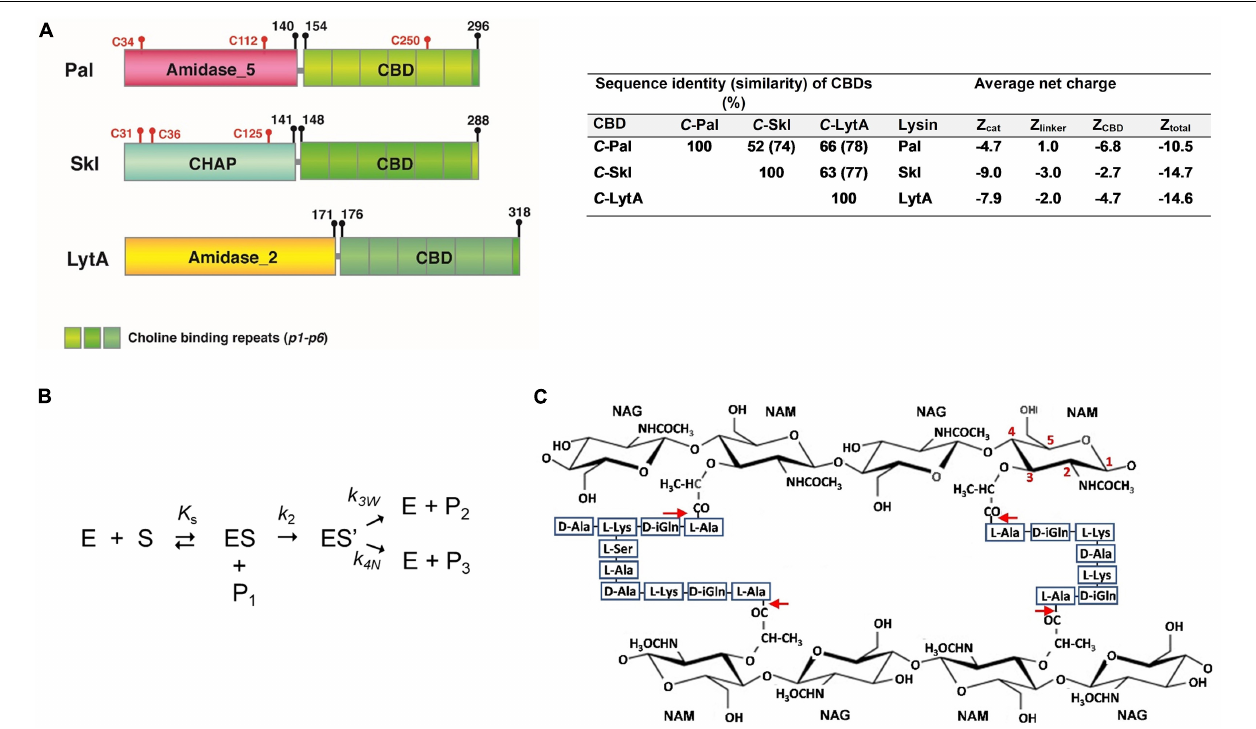
FIGURE 1 | (A) Schematic representation of Pal, Skl, and LytA NAM-amidase structures. Domains [ Amidase_5 (PF05382), CHAP (PF05257), Amidase_2 (PF01510)], choline-binding repeats (PF01473), and linkers are specified by different colors. Initial and final amino acids and cysteine positions are indicated. Sequence similarity between domains and average net charges are summarized on the right side. (B) Schematic representation of the reaction pathway for the hydrolysis by cysteine-peptidases. E and S are the free enzyme and the substrate, ES the non-covalent enzyme-substrate complex, ES’ the acyl-enzyme formed by the nucleophilic attack of the catalytic cysteine, P 1 the leaving amine product, P 2 the acyl product formed by water attack, and K s , k 2 , and k 3 w the dissociation constant of the non-covalent complex, the acylation constant, and the water-mediated deacylation constant, respectively. P 3 is the product resulting from the attack of the acyl-enzyme by other nucleophile, and k 4 w the respective first-order rate constant. (C) Schematic representation of pneumococcal peptidoglycan. Red arrows indicate the cleavage sites for NAM-amidases. NAG and NAM stand for N -acetylglucosamine and N -acetylmuramic acid. Cross-linking of stem peptides takes place, mainly, by Ser–Ala, and Ala–Ala dipeptides, or by direct binding of D-Ala to L-Lys moieties. Teichoic acids are covalently attached to position 6 of